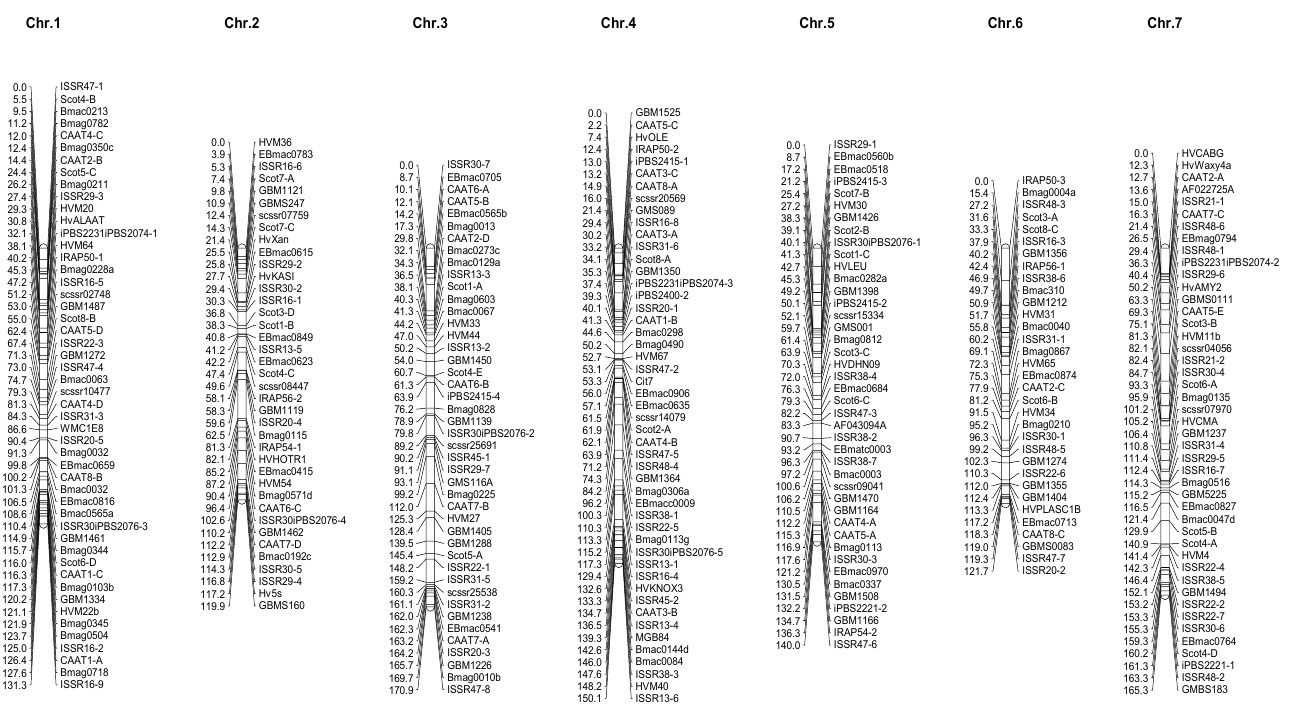
Figure 3. Linkage maps of barley chromosomes based on SSR, ISSR, IRAP, iPBS, CAAT, and SCoT markers in the RIL population caused by the Kavir and Badia crosses.